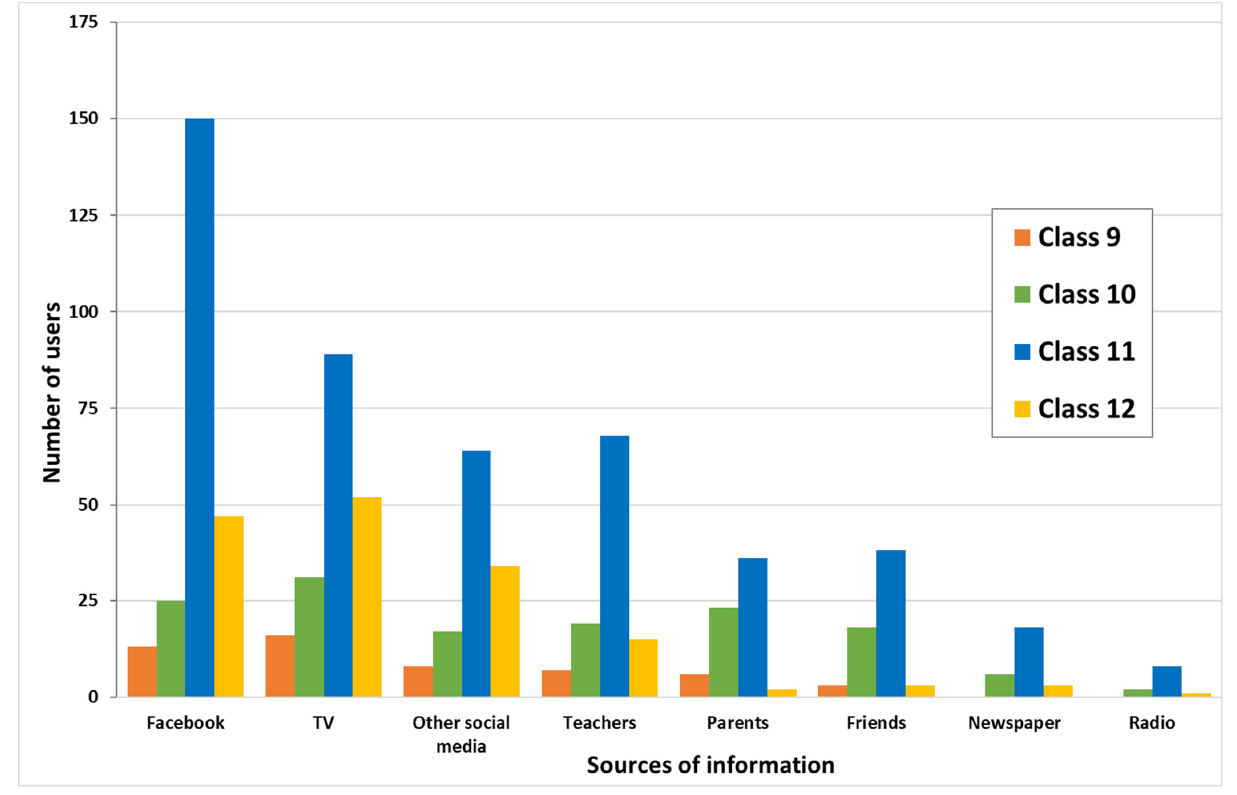
Figure 1. Different sources of information on hand hygiene and mask use reported by the students of Mongar Higher Secondary School, 2022. TV, television.